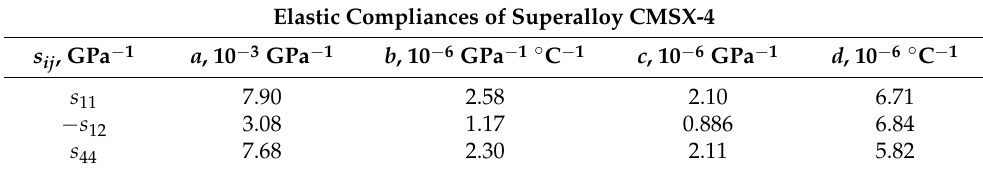
Table 4. Fitted parameters of Equation (11) for the γ -matrix.